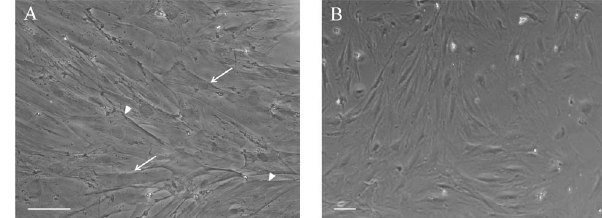
Figure 1. Astrocyte morphology. ( A, B ) Under normal conditions, primary adult astrocytes present a polygonal to fusiform and flat morphology, as shown by phase contrast microscopy. We did not observe morphological alterations during the culture period. The arrowhead indicates a polygonal cell, and the arrow indicates a fusiform cell. Scale bars: (A)=100 m m, (B)=50 m